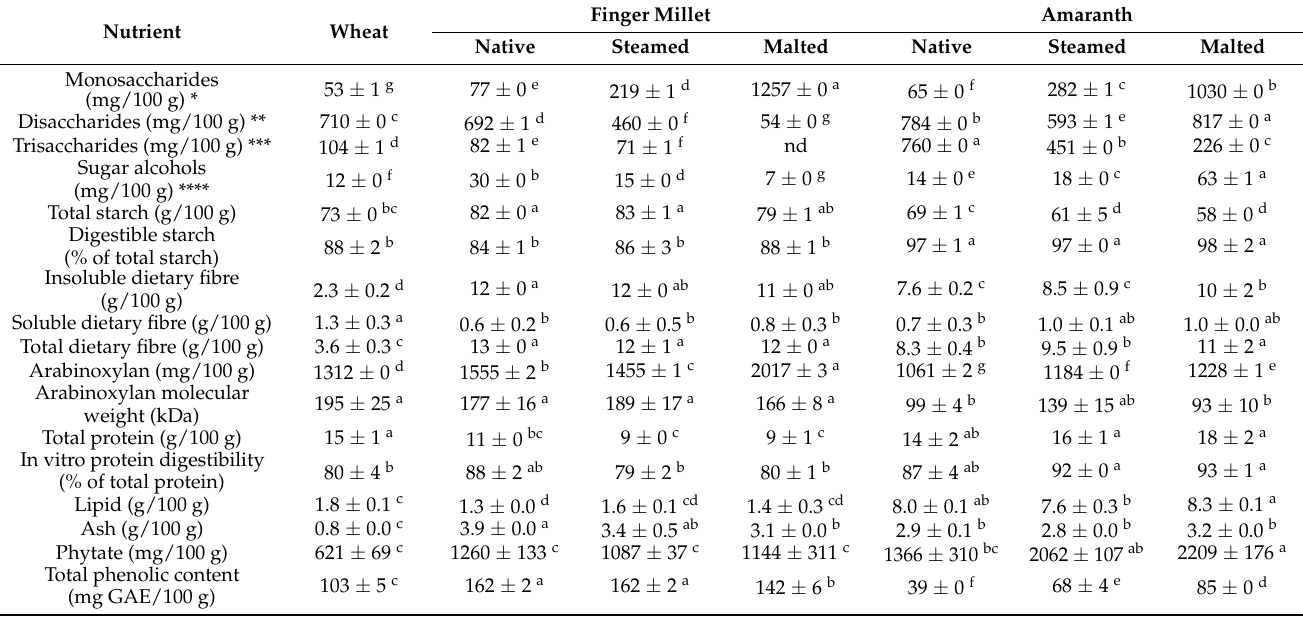
Table 1. Nutrient composition (based on dry weight) and quality of wheat, finger millet and ama- ranth